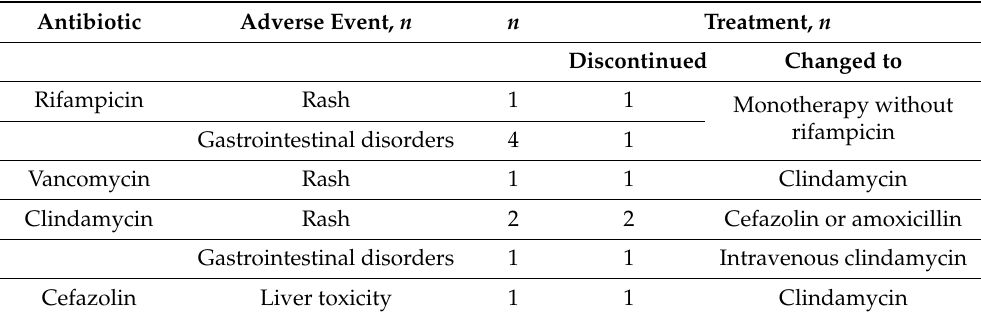
Table 6. Antibiotic-related adverse events: type, grade and treatment changes